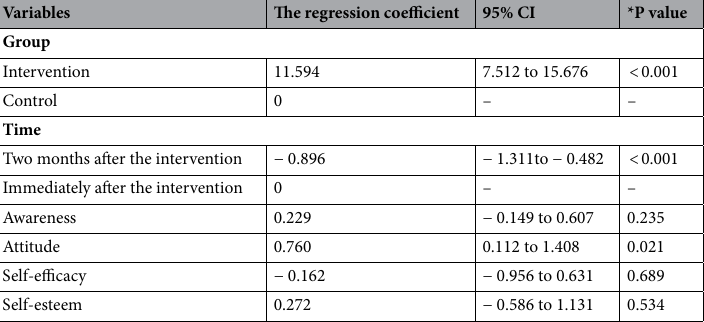
Table 5. Effectiveness of the intervention on improving the high-risk behaviors via model constructs in different group and time period. CI confidence interval; *Testing significant effect between groups and time